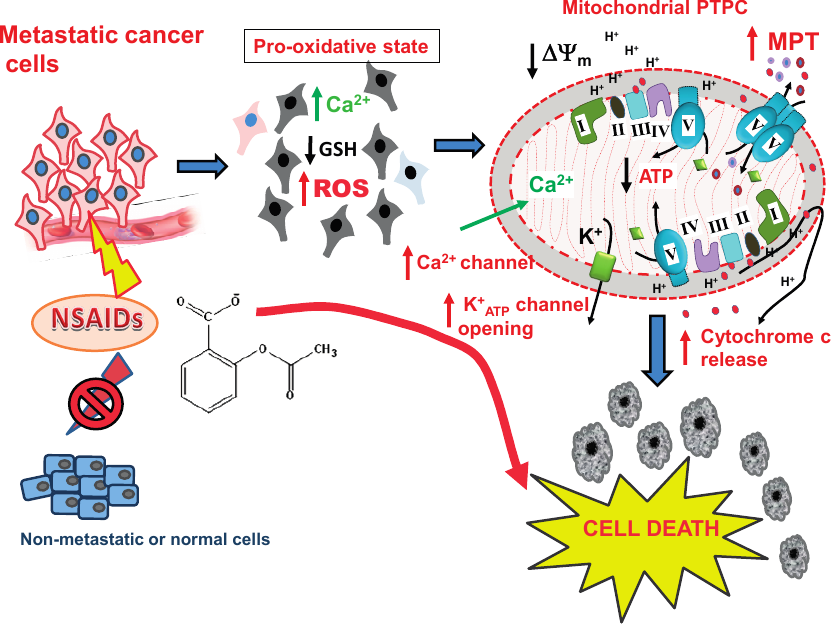
Figure 3. NSAIDs as mitochondrially targeted drugs in metastatic cells. After NSAID treatment, a heightened pro-oxidative status is induced in the metastatic cells, but not in non-metastatic tumor cells. The events ensuing in the metastastic cells include decreasing levels of GSH, critical changes in the Cysteine-thiol/disulfide bond status of key proteins and increasing ROS production, which is followed by Ca 2+ overload, collapse of Δψ m , opening of the PTPC, release of cytochrome c and the other apoptosis-inducing factors leading to the death and elimination of these cells. Abbreviations: NSAIDS, non-steroidal anti-inflammatory drugs; GSH, reduced glutathione; ROS, reactive oxygen species, PTPC, mitochondrial permeability transition pore complex, MPT, mitochondrial membrane permeability